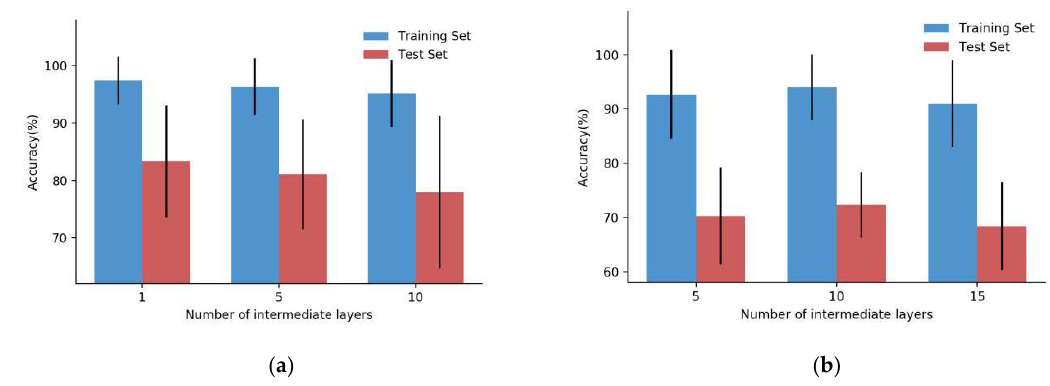
Figure 14. Comparison of accuracy with different numbers of intermediate layers by FCCDNNs. ( a ) C. elegans dataset, ( b ) zebrafish dataset.